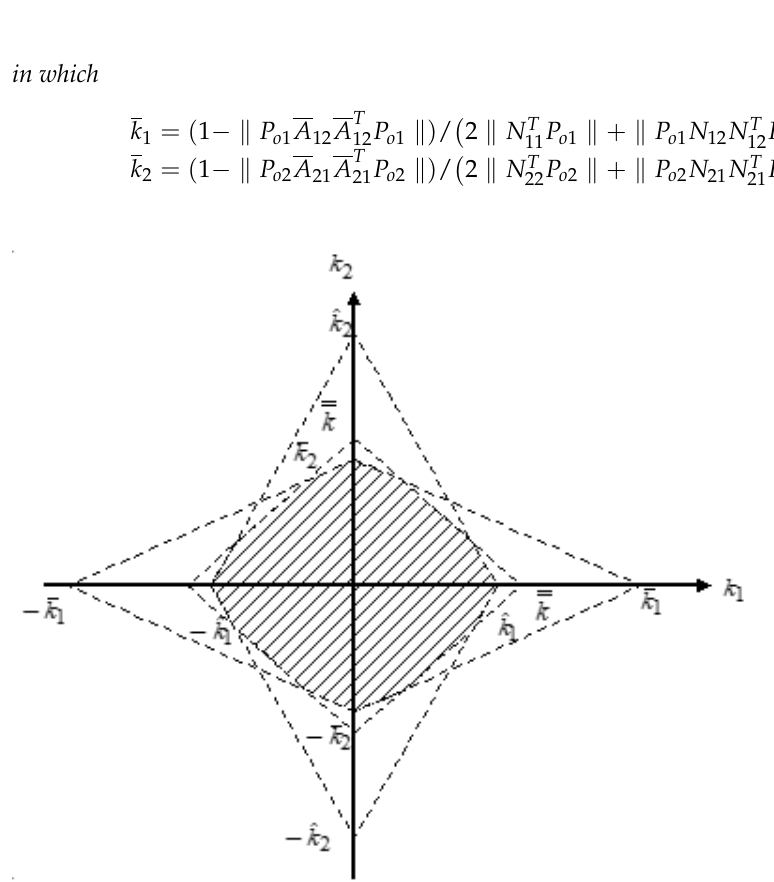
Figure 2. The admissible region k 1 and k 2 for the observer-based controller (10).